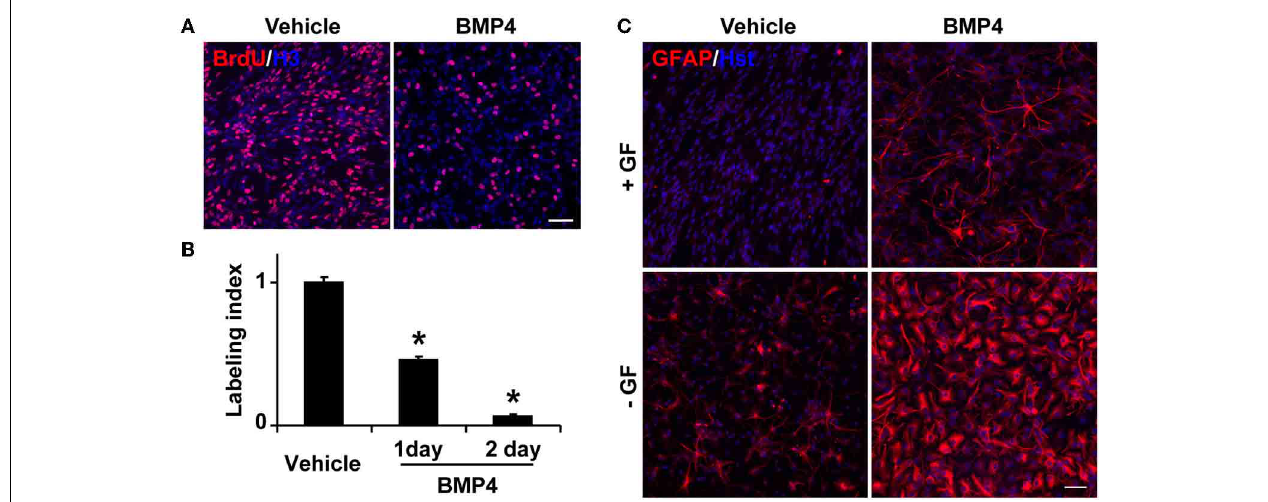
FIGURE 4 | BMP4 inhibits proliferation and promotes astrogenesis of cultured NSCs. (A) Representative BrdU-labeled cells treated with vehicle or BMP4. Nuclei were stained with an antibody against histone H3 (H3). (B) The labeling index was calculated based on the percentage of BrdU + cells in BMP4- vs. vehicle-treated NSCs in growth media at the indicated time